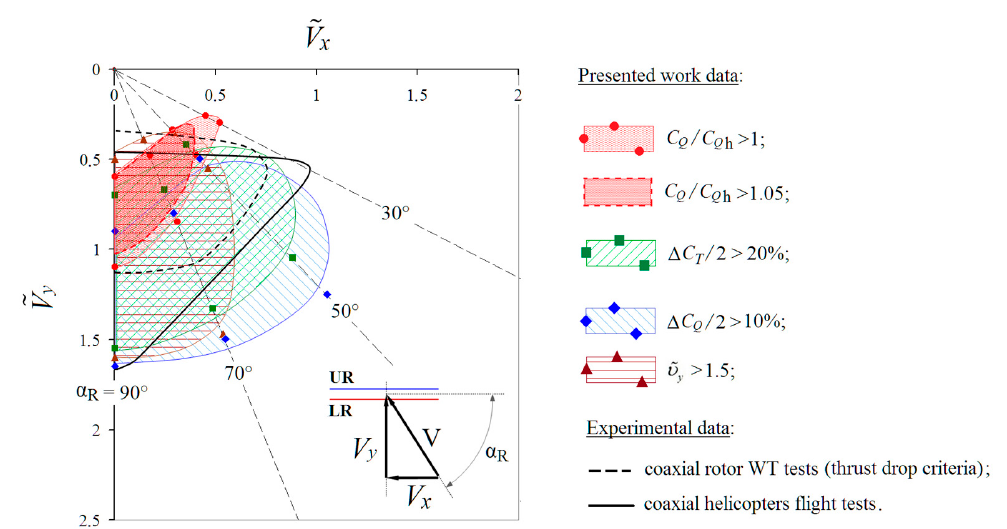
Figure 17. Calculated and experimental [7] VRS boundaries based on various criteria.